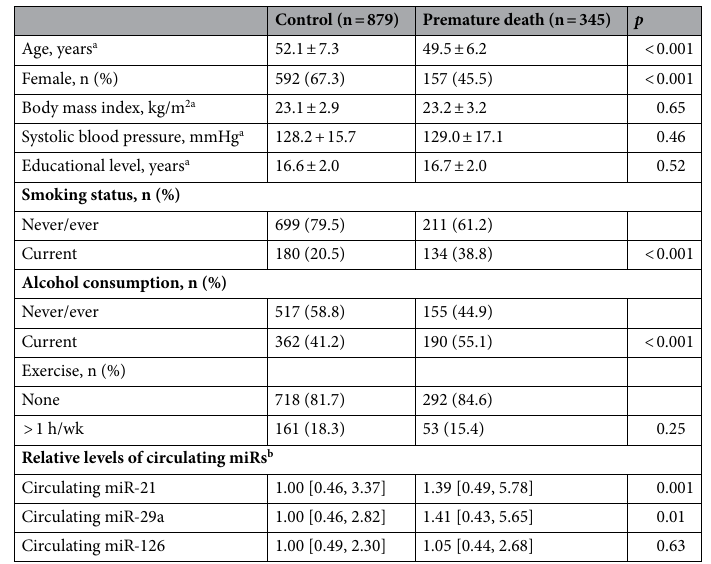
Table 1. Characteristics of subjects for the analysis of premature death. a Data are expressed as mean value ± standard deviation. b Data are expressed as relative values and 25th–75th percentiles in parentheses. The circulating miRNA levels were calibrated relative to